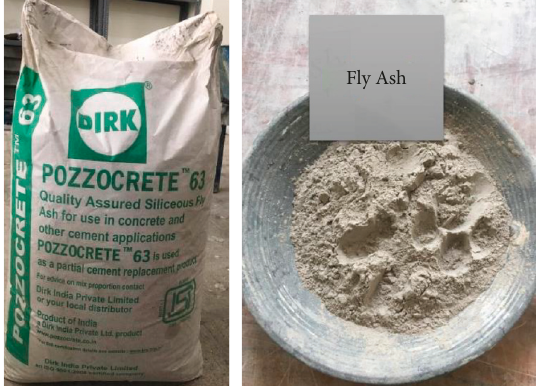
Figure 2: Fly ash was used in this study.